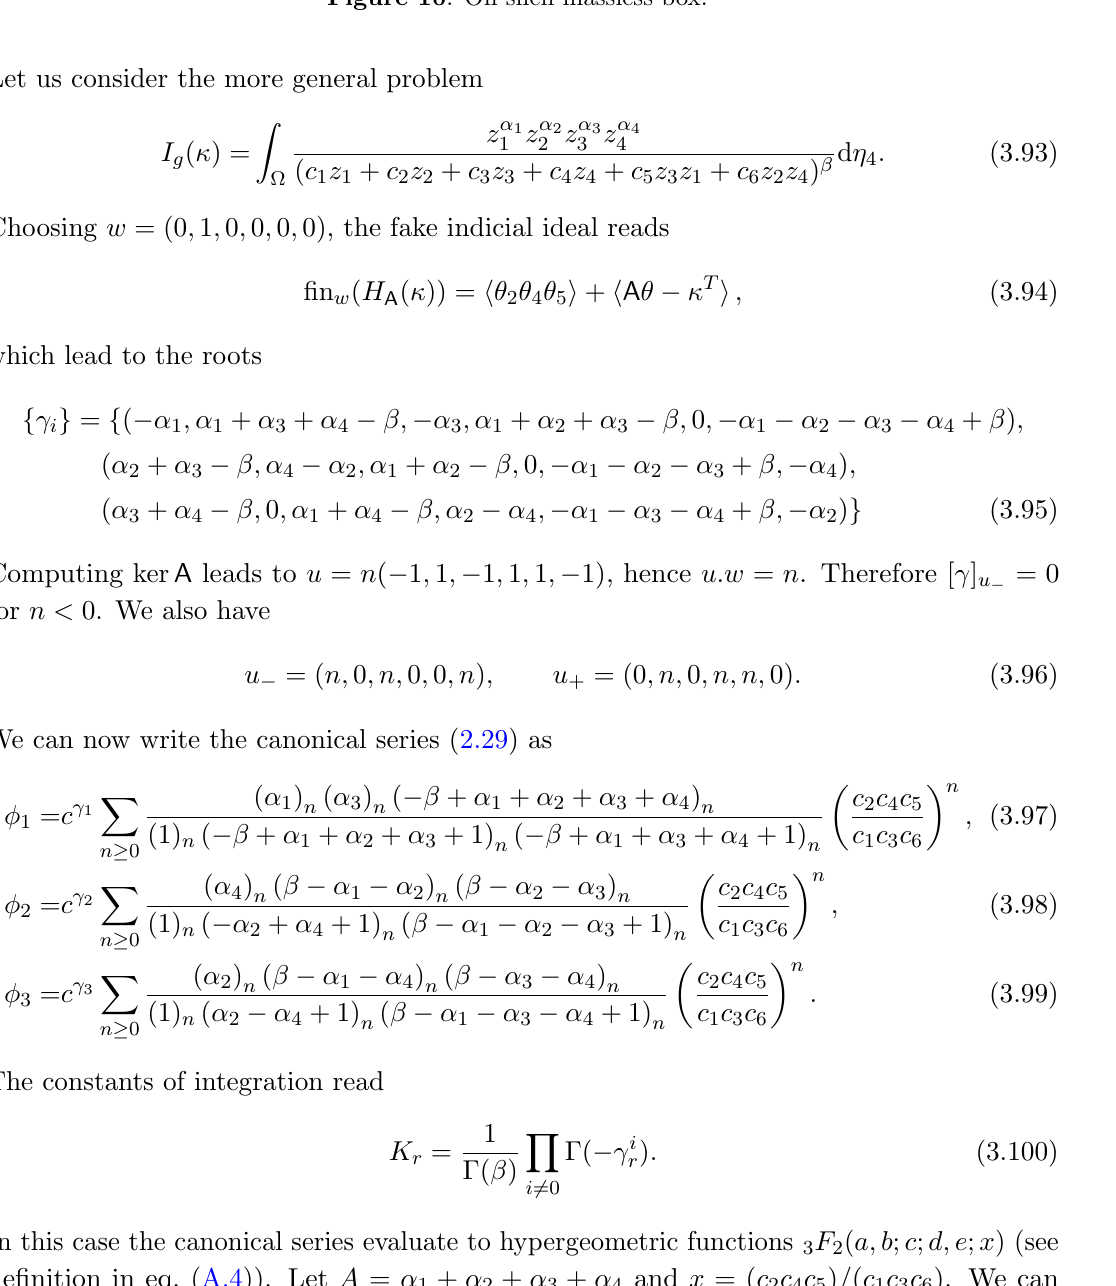
Figure 10 . On shell massless